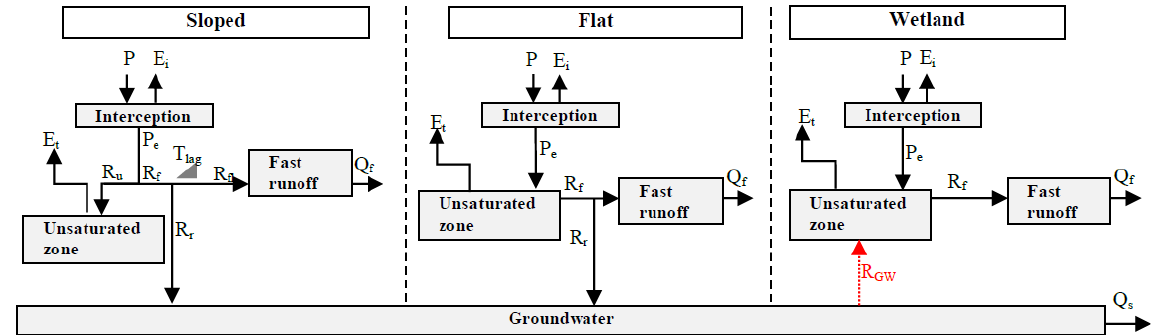
Figure 2. Schematization of the model structure applied to each grid cell. Symbol explanation: precipitation ( P ), effective precipitation ( P e ), interception evaporation ( E i ), plant transpiration ( E t ), infiltration into the unsaturated root zone ( R u ), drainage to fast runoff component ( R f ), delayed fast runoff ( R fl ), lag time ( T lag ), groundwater recharge ( R r ), upwelling groundwater flux ( R GW ), fast runoff ( Q f ) and groundwa- ter/slow runoff ( Q s